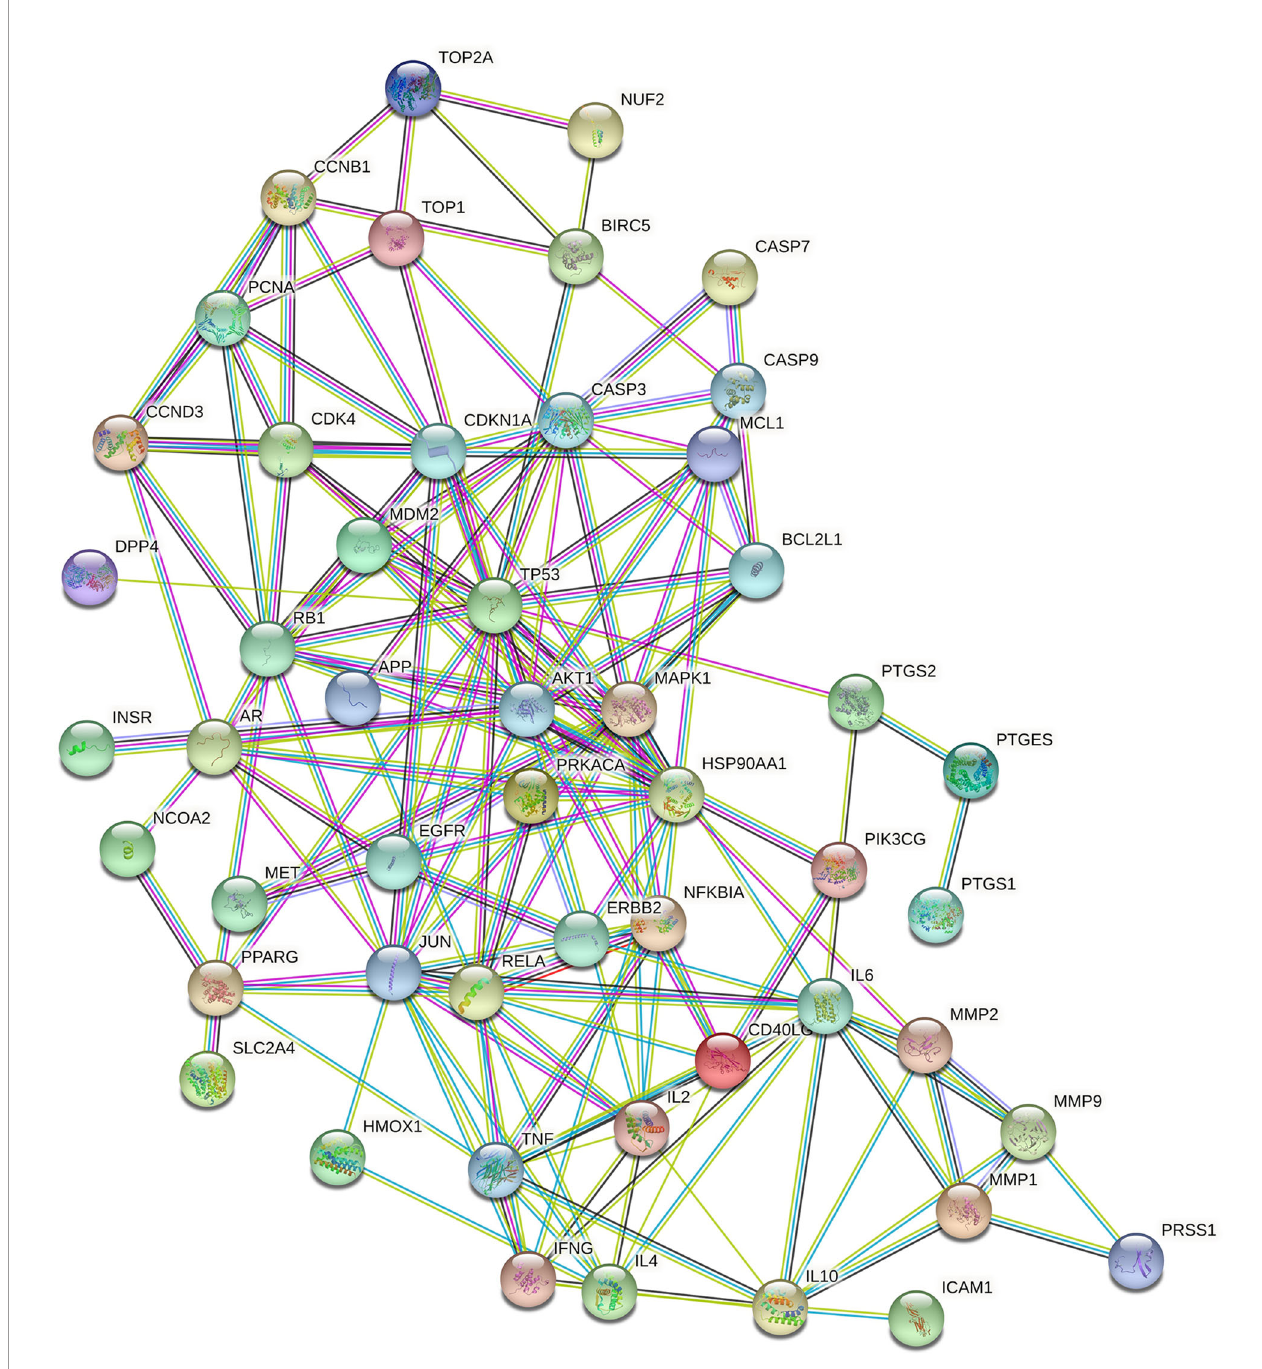
FIGURE 4 | The PPI network of